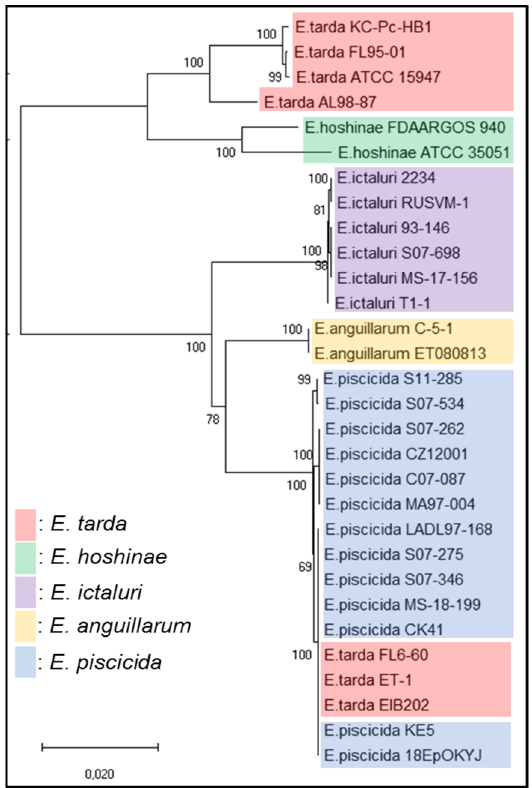
Figure 2. Phylogenetic tree generated by the neighbor-joining method on the basis of the waa cluster sequence.